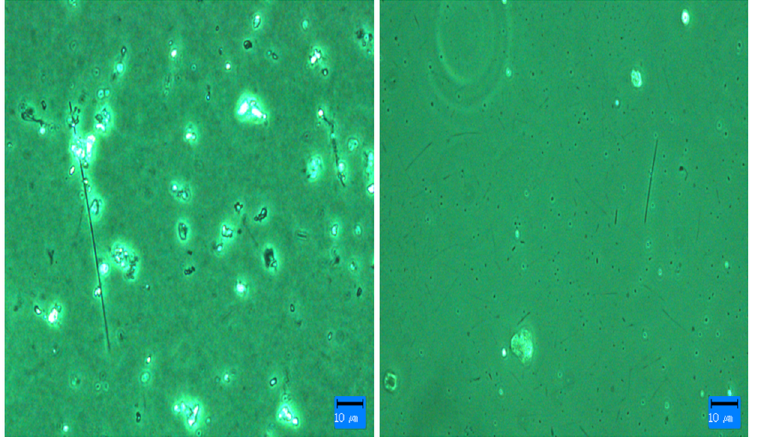
Fig 5. Separation of fibers from particulate matter with the HY-DMA. Left: Filter preparedfor PCM (400 × ) analysis(air not passed through HY-DMA). Right: Filter preparedfor PCM (400 × )analysis(air passed through HY-DMA and particulatematter removed).